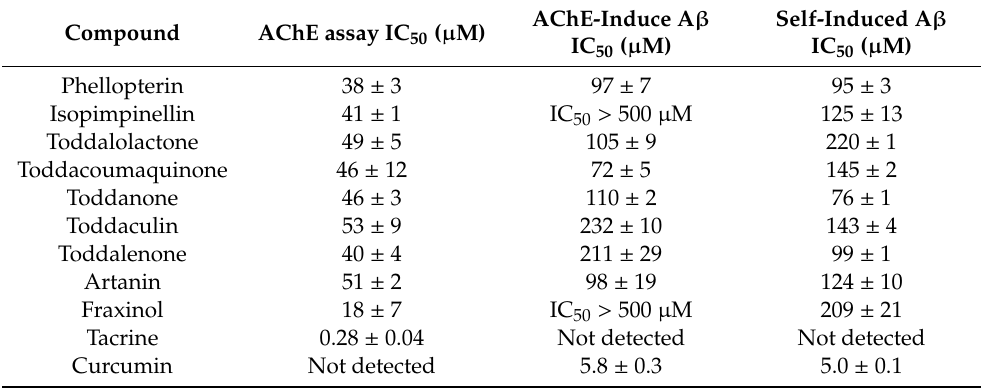
Table 1. Biological activities of coumarins related to Alzheimer’s disease